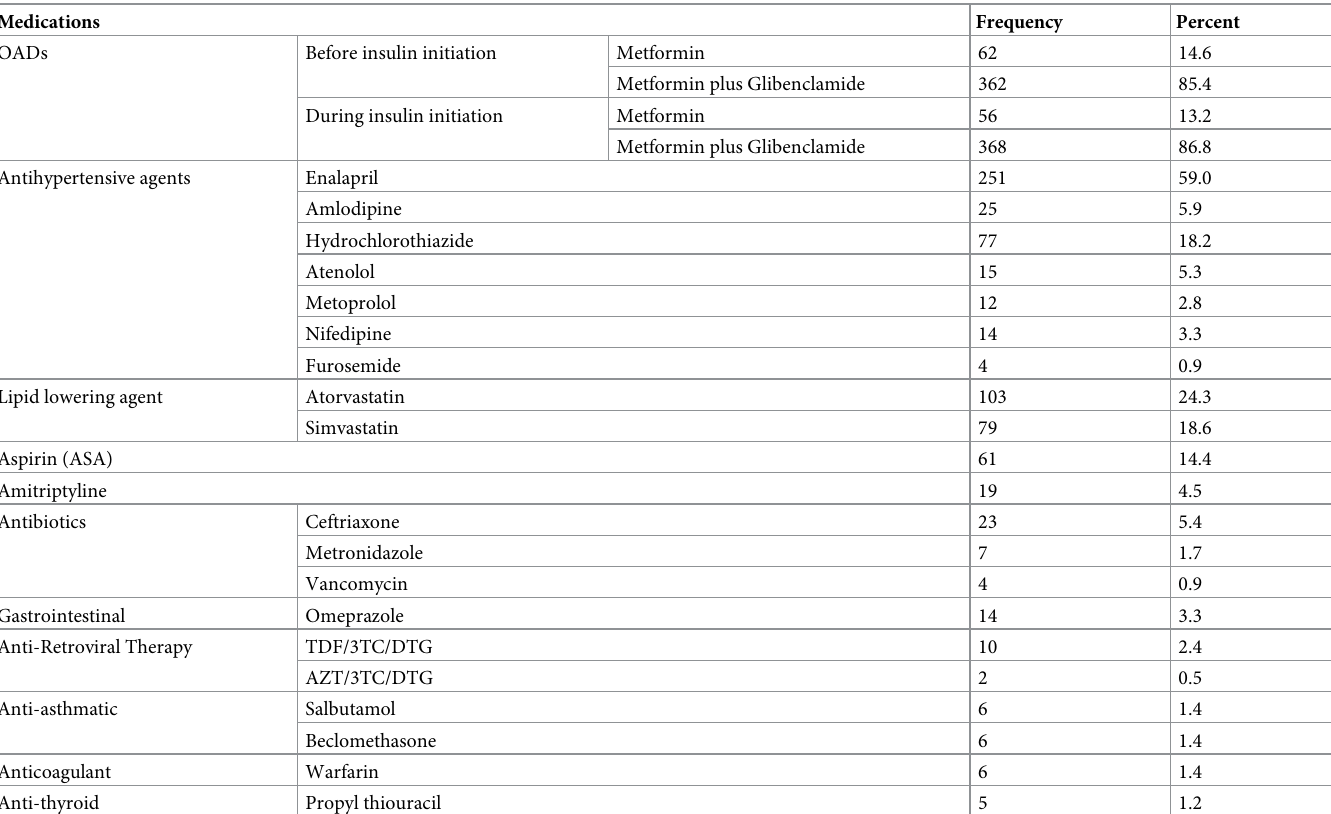
Table 2. Distribution of baseline medications used to treat study participants (N = 424).